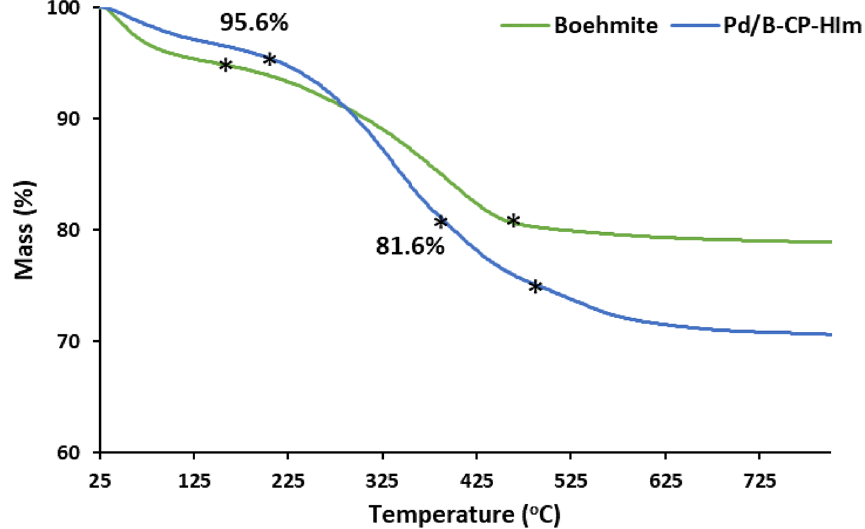
Figure 7. TG curves of boehmite and Pd/B-CP-HIm.